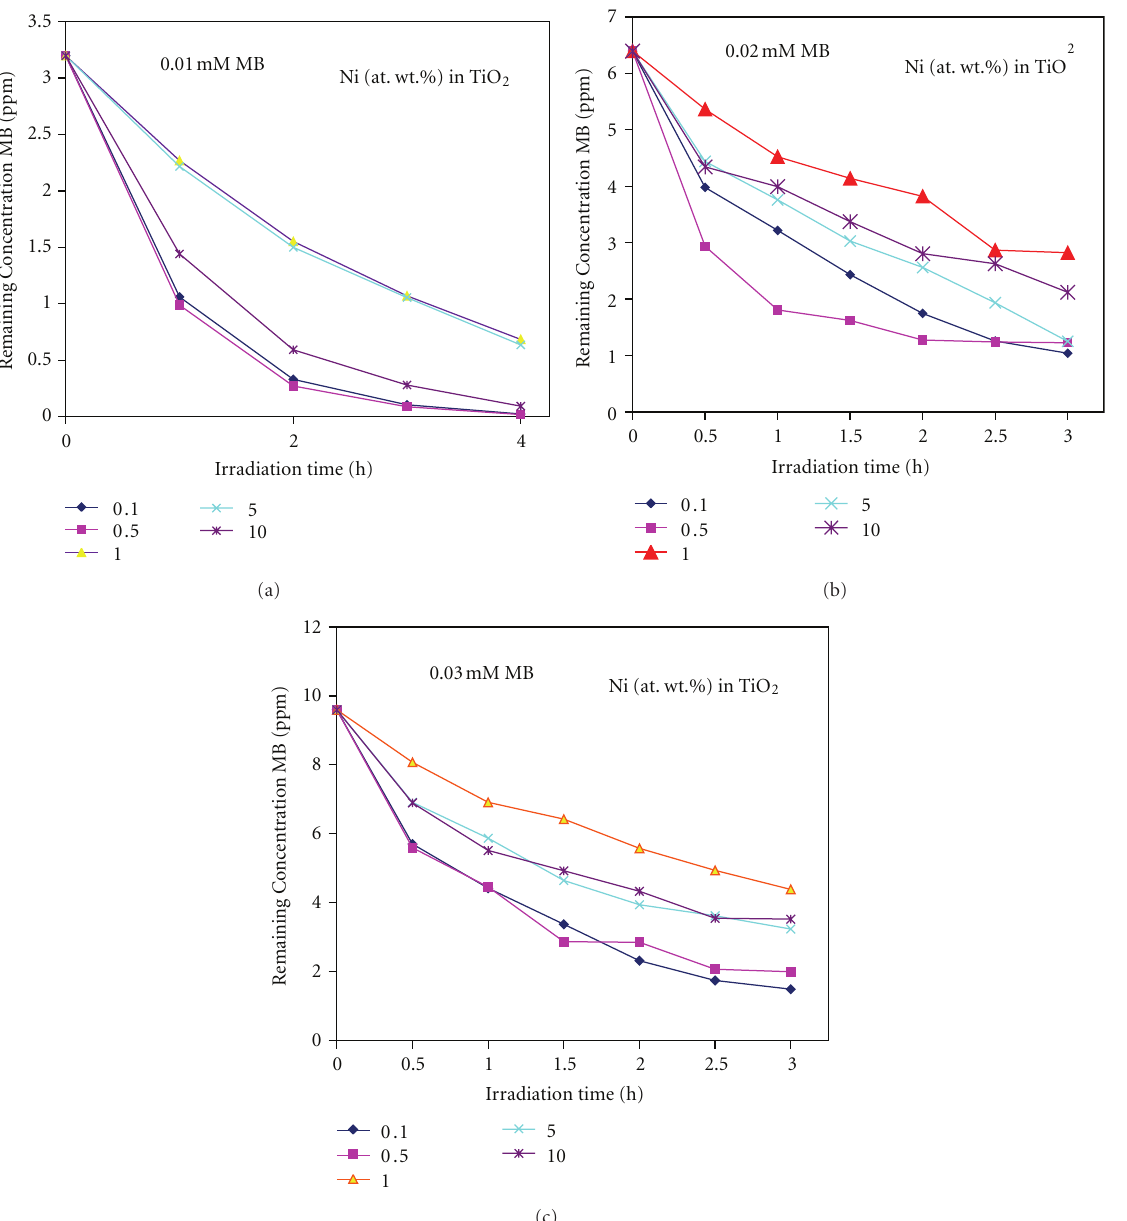
Figure 11: E ff ect of the concentration of methylene blue (MB) on photocatalytic ability of Ni-doped TiO 2 (Ni = 0.1, 0.5, 1, 5, and 10 at. wt.%) powders formed at 550 ◦ C for 6h. (a) 0.01 mM, (b) 0.02 mM, and (c) 0.03 mM MB solutions. concentration from 0.1 to 10%. The isoelectric point of TiO 2 lies in pH less than 6.8 [51, 52]. The solution at pH 7 renders TiO 2 powder surface a negative charge, resulting in negative ζ values. The change of ζ values with increase of Ni-dopant concentration suggests that the isoelectric point of this powder is changing with the increase of Ni concentration. medium can be shown with the following